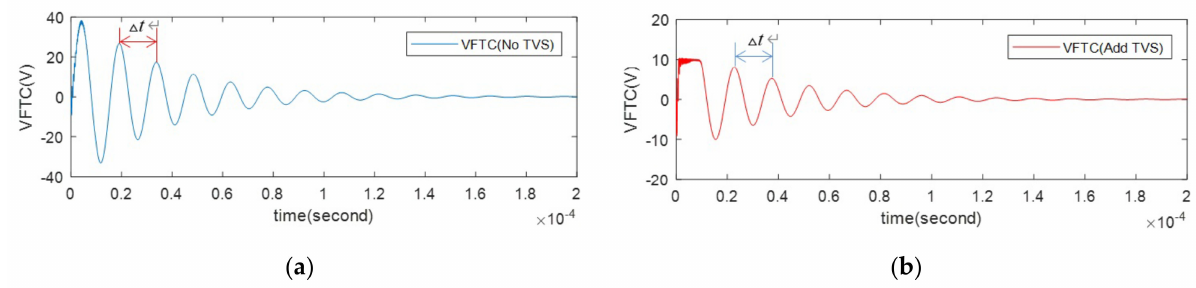
Figure 7. VFTC waveforms at the secondary port of the Rogowski coil (S. No2). ( a ) No TVS; ( b ) added TVS.